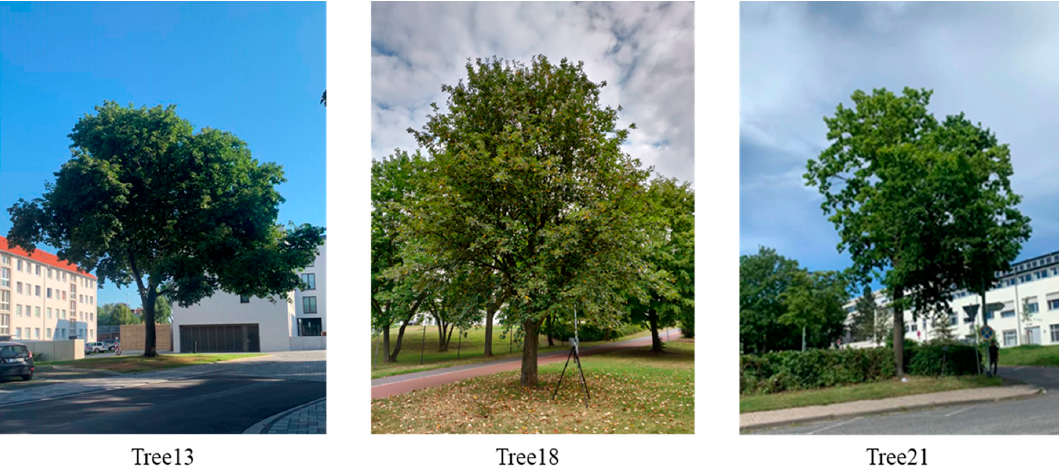
Figure 2. Illustration of the variation of crown sizes, shapes and densities among the sample trees.